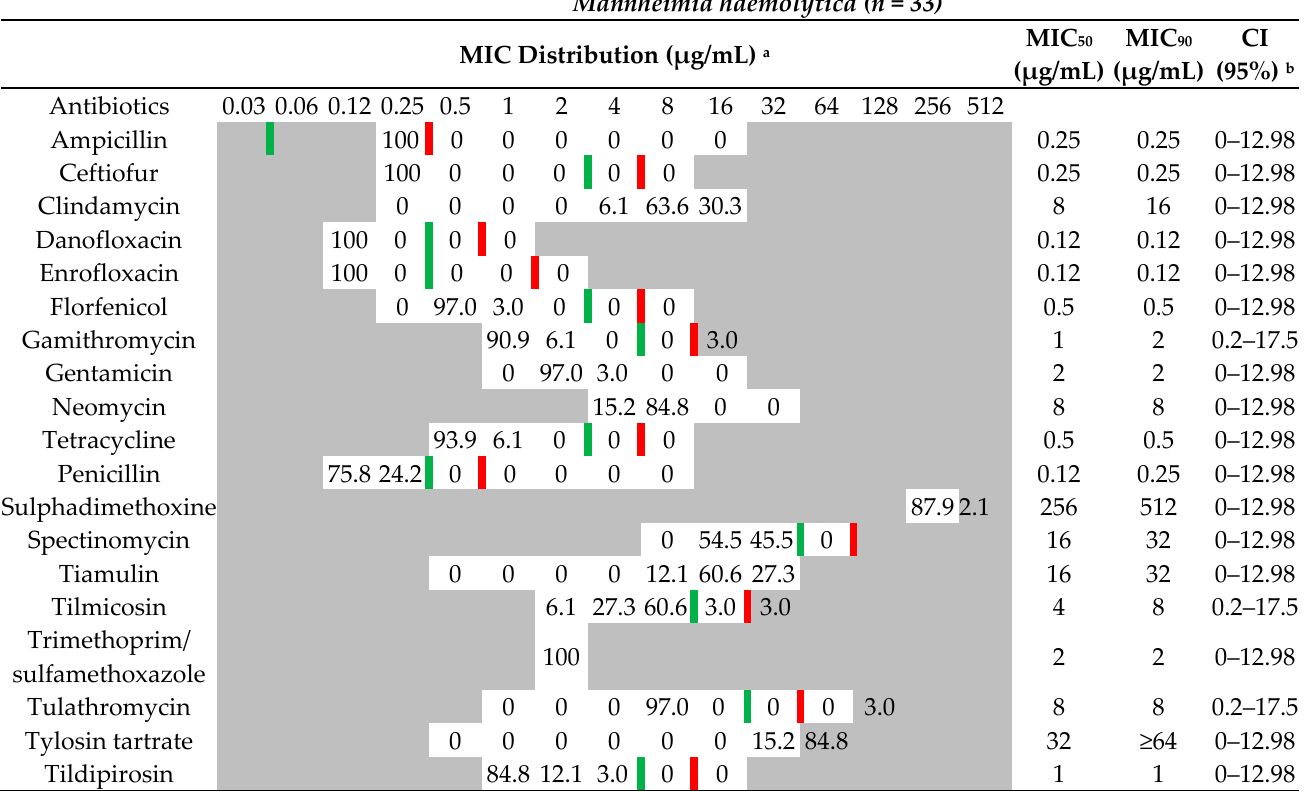
a The dilution ranges tested for the percentage of the isolates are those contained in the white area. Values above this range indicate MIC values higher than the highest concentration tested. Values corresponding to the lowest concentration tested indicated MIC values lower or equal to the lowest concentration within the range. When available, susceptible and re- sistance breakpoints are indicated in vertical green and red lines, respectively. Cut-off values were used according to CLSI document VET08. b Confidence interval based on % resistant.